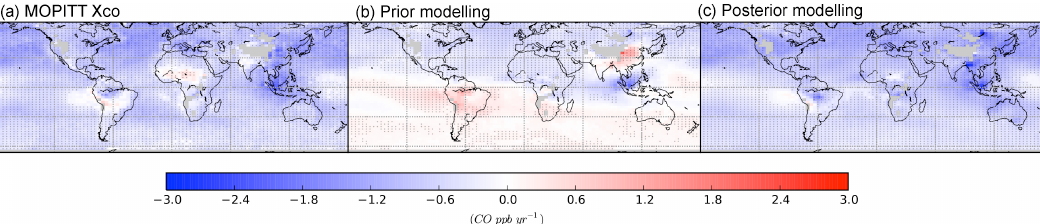
Figure 5. Distribution of CO column mixing ratio trends from 2002 to 2011 in (a) MOPITTv6 retrievals, (b) the prior simulation and (c) the posterior simulation. Black crosses indicate significance at the 95% confidence